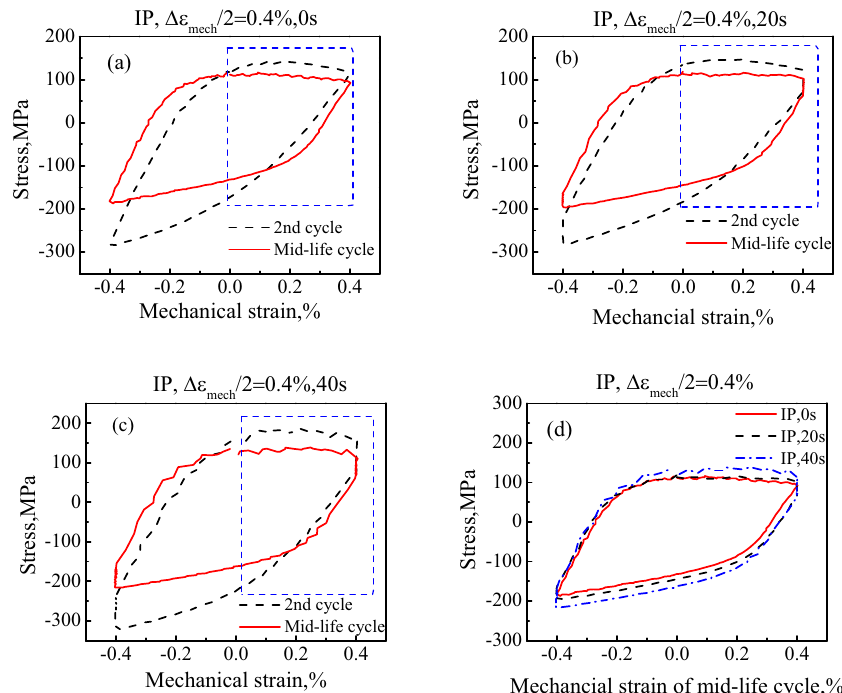
Figure 7: Typical hysteresis loops at the mechanical strain amplitude of 0.4% with dwell time of ( a ) 0 s, ( b ) 20 s, ( c ) 40 s and ( d ) comparison of the three hysteresis